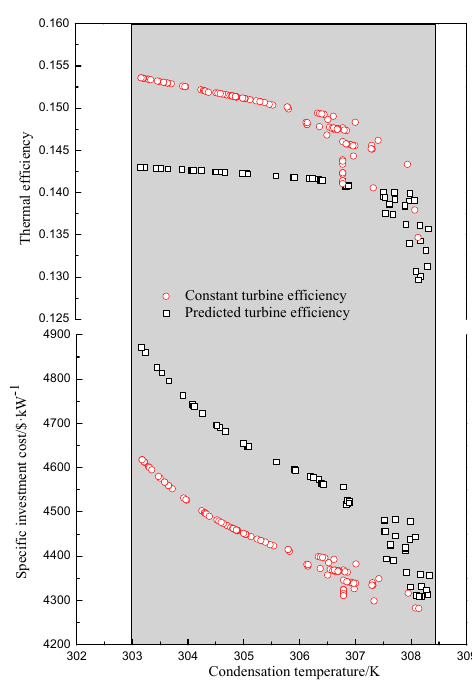
Appl. Sci. 2018 , 8 , x FOR PEER REVIEW Figure 10. Distribution of optimal condensation temperature. Figure 10. Distribution of optimal condensation temperature.